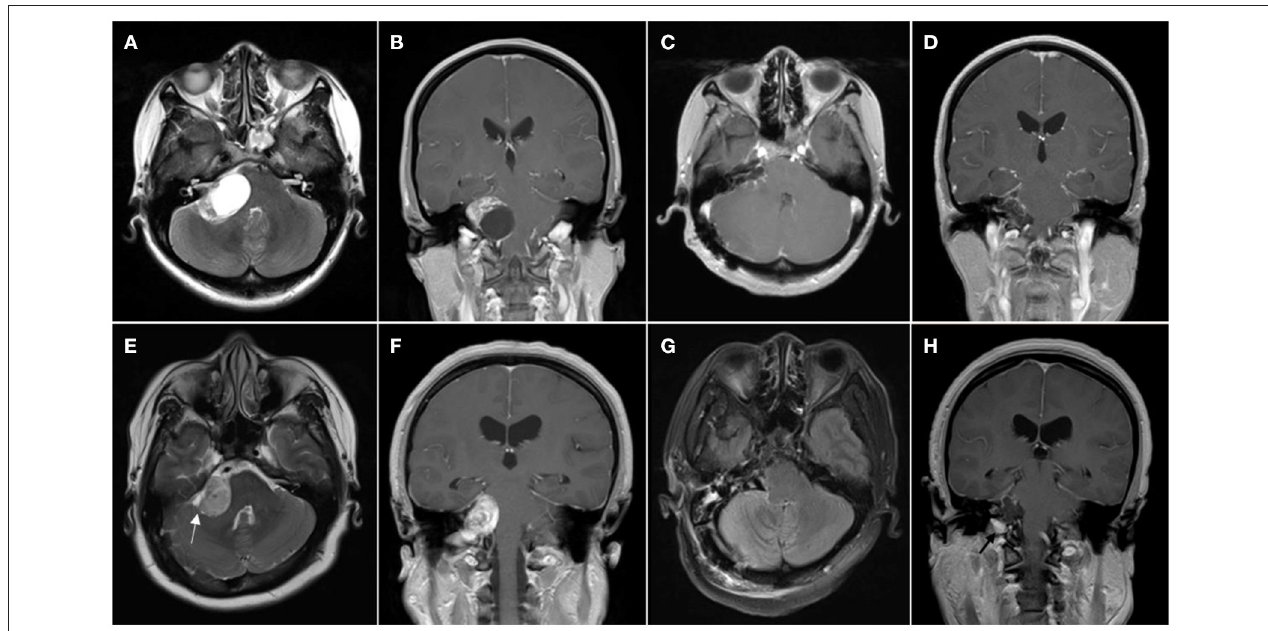
FIGURE 1 | Patient with cystic vestibular schwannoma. (A,B) Preoperative MR images showing cystic vestibular schwannoma; (C,D) Postoperative MR images showing resection of the tumor. (E–H) Patient with solid vestibular schwannoma; (E,F) Preoperative MR images showing solid vestibular schwannoma, cerebrospinal fluid (CSF) cleft sign surrounding the tumor is marked with the white arrowhead; and (G,H) Postoperative MR images showing resection of the tumor and left tumor remnant is marked with the black